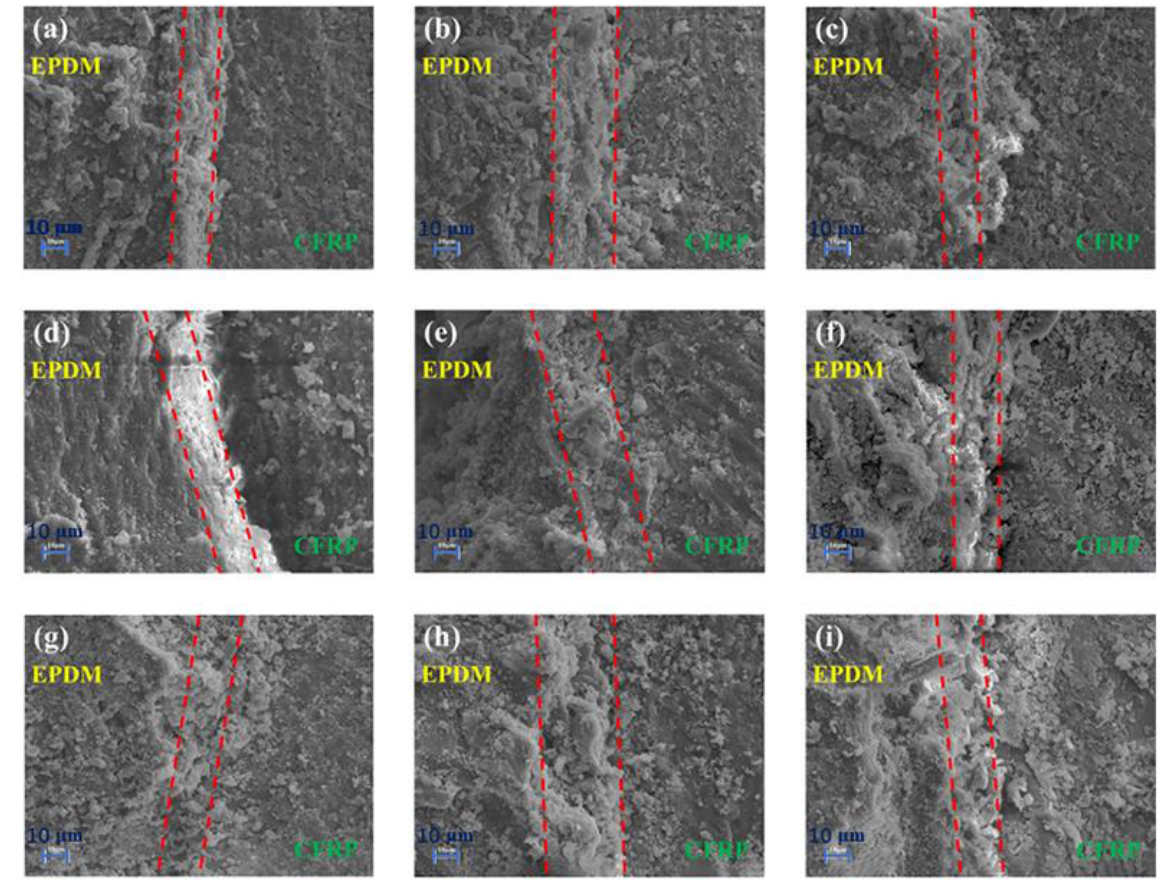
Figure 8. SEM images of CFRP/EPDM composite cross-sections. ( a ) CFRP/EPDM/DCP, 160 °C, 1 h. ( b ) CFRP/EPDM/DCP/S, 160 °C, 1 h. ( c ) CFRP/EPDM/DCP/TAIC, 160 °C, 1 h. ( d ) CFRP/EPDM/DCP,